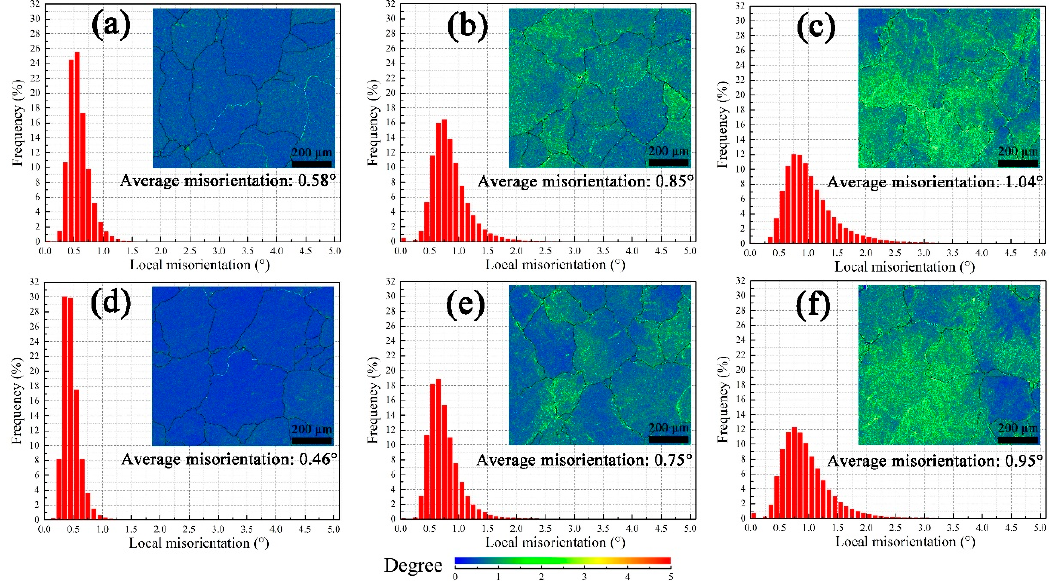
Figure 4. KAM maps before creep, pre-treatment: ( a ) 3#, ( b ) 6#, ( c ) 9#, ( d ) 3A#, ( e ) 6A#, ( f ) 9A#. After the 12 h compressive creep test, the average local misorientation of all samples increases, as illustrated in Figure 5. Thus, the dynamic recovery and recrystallization have not consumed the dislocations induced by creep. Compared between Figures 4 and 5, on the one hand, the amplitudes are 0.41°, 0.26°, and 0.22° for samples 3#, 6#, and 9#, respectively. On the other hand, the amplitude is slightly smaller for samples 3A#, 6A#, and 9A# (0.40°, 0.27°, and 0.02°, respectively).